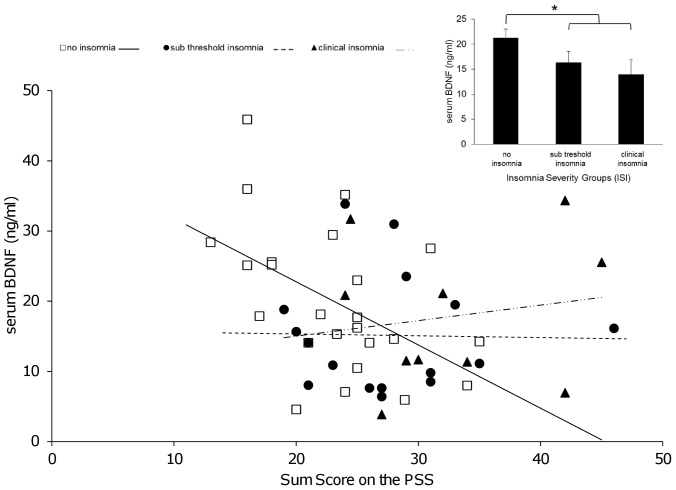
Correlation between serum BDNF levels and scores on the Perceived Stress Scale (PSS) by insomnia severity groups according to the Insomnia Severity Index (ISI).Analyses showed a significant correlation (partial correlation controlled for smoking) between BDNF and stress only in subjects with no insomnia (rp = −0.511, p = 0.013) compared to subjects with sub threshold (rp = 0.069, p = 0.814) or clinical insomnia (rp = 0.199, p = 0.608). White squares represent subjects with no insomnia, black circles represent subjects with sub threshold and black triangles represent subjects with clinical insomnia. (Inset) Mean serum BDNF levels of the insomnia severity groups. Plotted means and standard errors estimated by ANCOVA with serum BDNF as dependent variable, insomnia severity group as independent variable and smoking as covariate. For all three insomnia severity groups the overall effect on serum BDNF was not significant (F(2) = 2.67; p = 0.080). Contrasts showed that serum BDNF levels in the group with no insomnia were significantly higher compared to the groups reporting sub threshold and clinical insomnia (F(1) = 5.33; p = 0.026); (no insomnia n = 24; sub threshold insomnia n = 16, clinical insomnia n = 10). * Denotes statistical significance at p<0.05